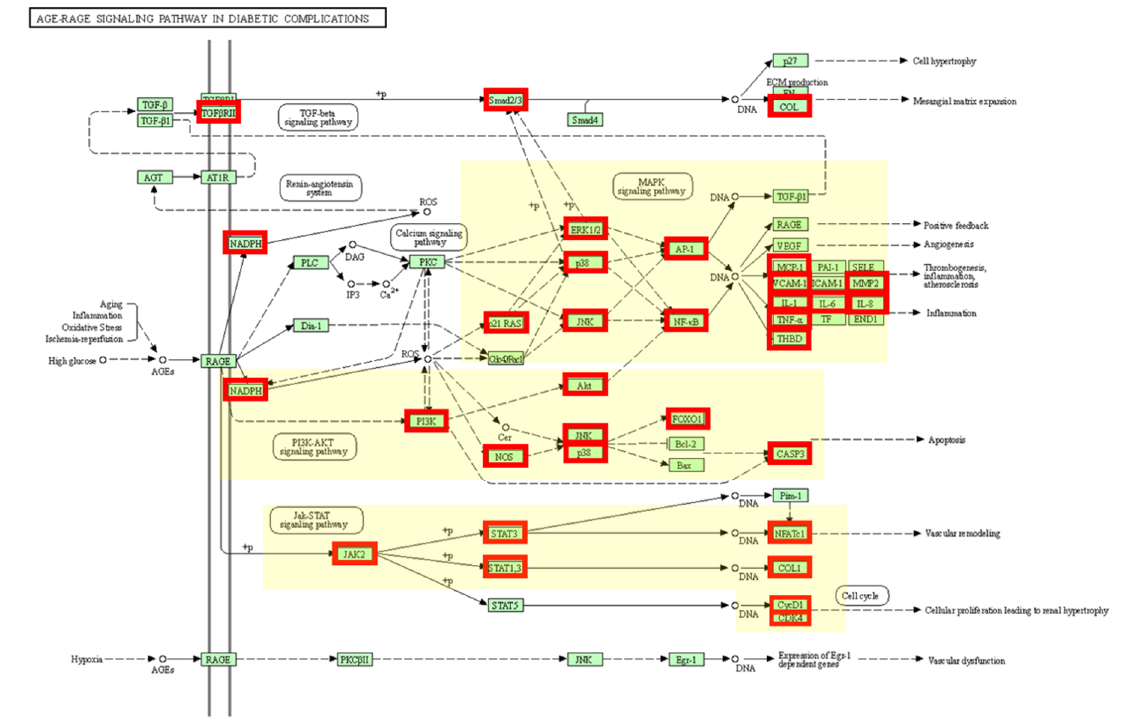
Figure 4. A diagram of the AGE-RAGE signaling pathway in diabetic complications. KEGG pathway: hsa04933. Matched genes are marked in red